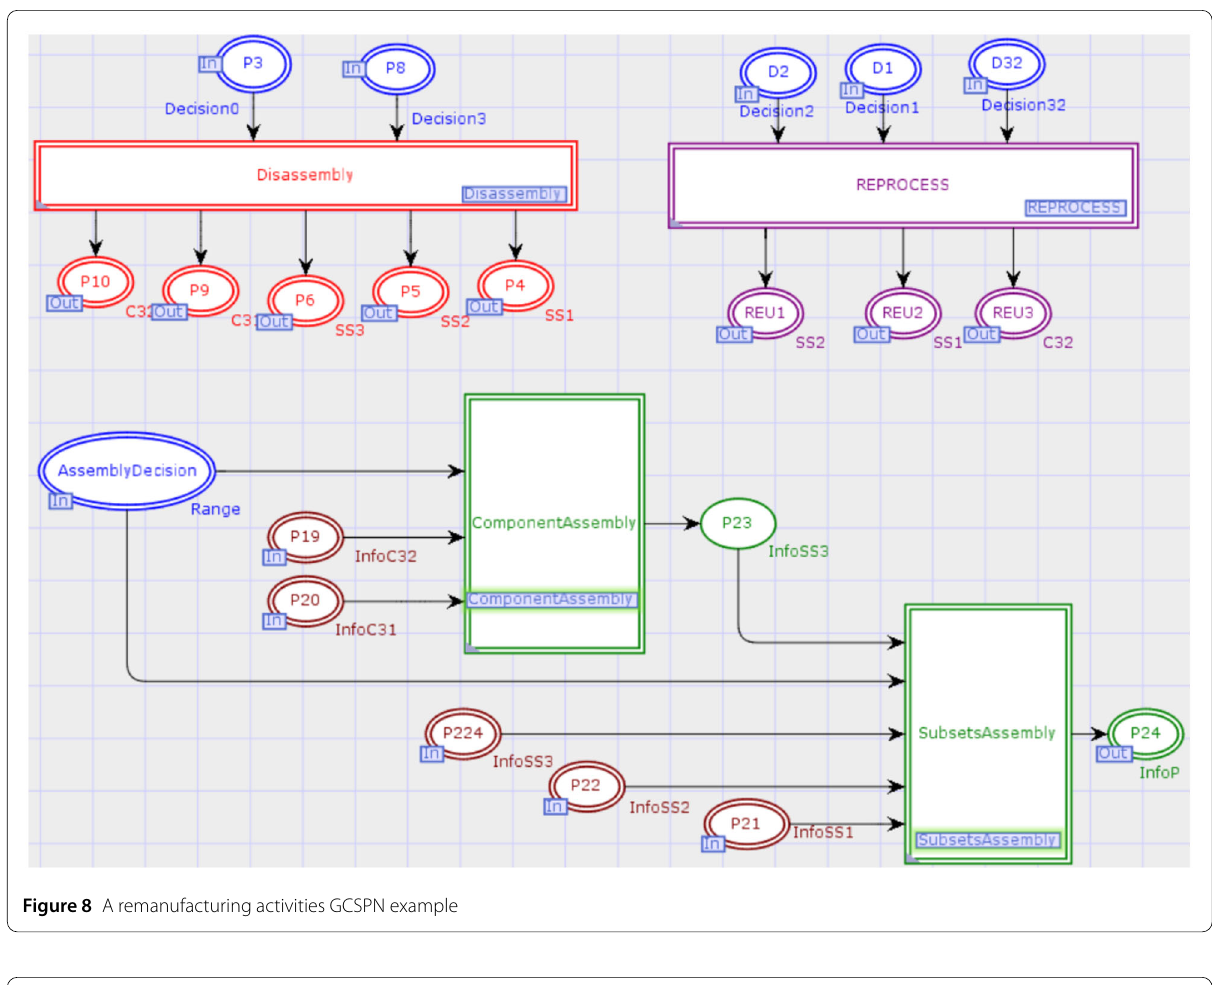
Figure 8 A remanufacturing activities GCSPN example